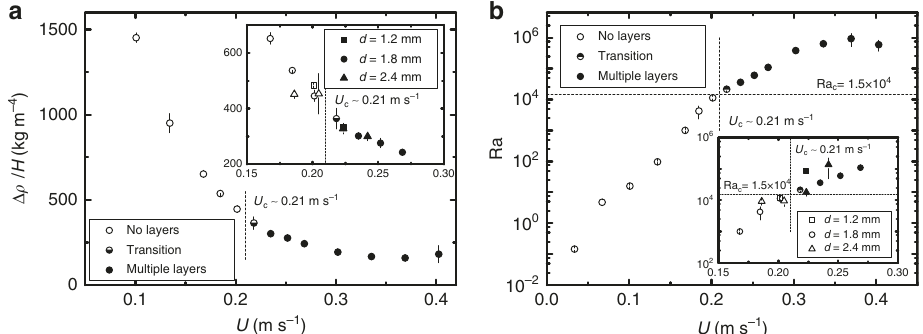
Fig. 3 Role of the injection velocity U . a The average density gradient, de fi ned as the density difference between the bottom and the top of the mixture relative to the mixture height H , as a function of U . b The Rayleigh number Ra , de fi ned based on the minimum density gradient and the maximum temperature difference in the mixture, vs. U . The hollow, half-solid and solid symbols refer to the observations, where, respectively, multiple layers are never, sometimes and always observed in the mixture. The squares, circles and triangles refer to different inner diameters of the injection needles d ¼ 1.2, 1.8 and 2.4 mm , respectively. The insets show a zoomed-in view around the transition region. The horizontal dashed line in ( b ) at Ra c ¼ 1 : 5 ´ 10 4 indicates the critical Rayleigh number reported in the literature 18 . Error bars correspond to standard derivations with n experiments with n ¼ 3 (cid:2) 5